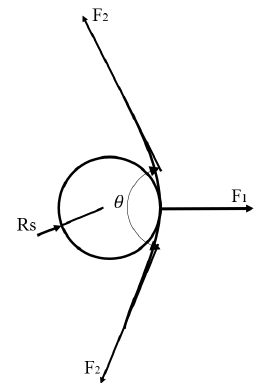
Figure 3. Schematic diagram of force analysis of pulverized coal.